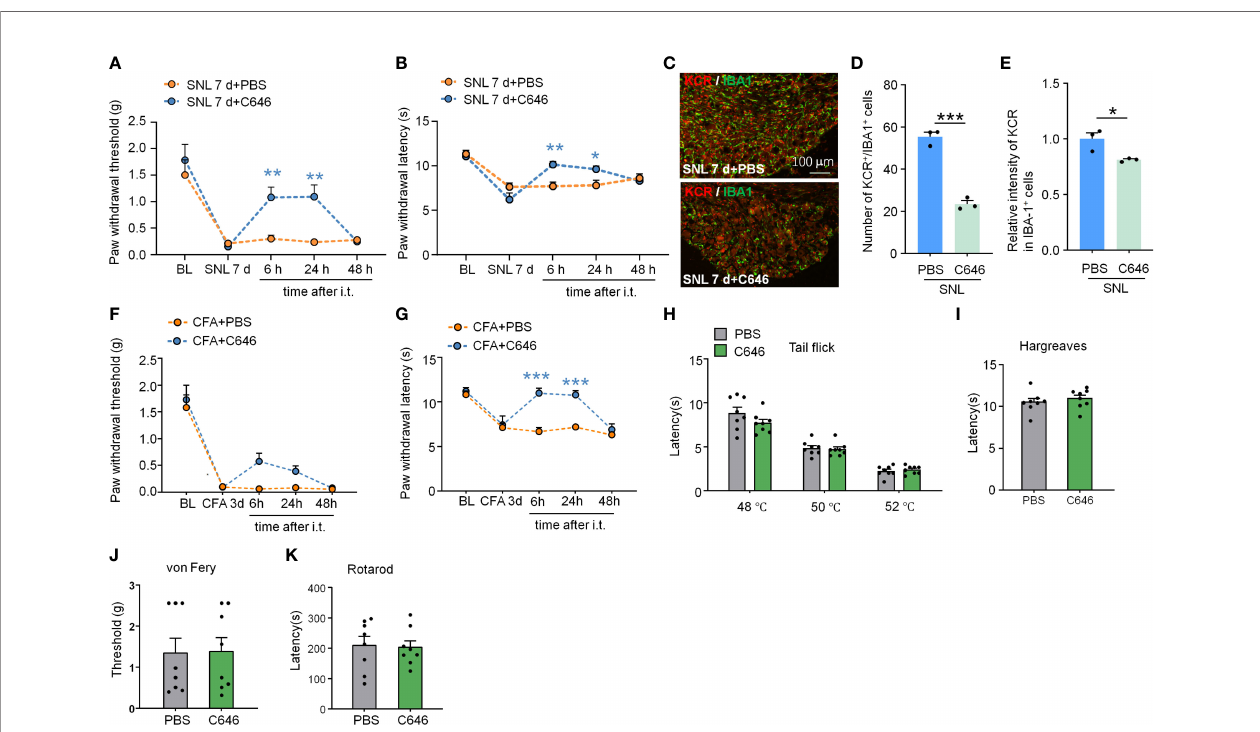
FIGURE 7 | Intrathecal administration of C646 attenuated SNL-induced neuropathic pain and CFA-induced in fl ammatory pain. (A, B) Intrathecal injection of C646 (2 m g) signi fi cantly relieved plantar mechanical pain and thermal pain hyperalgesia induced by SNL. * P <0.05, ** P <0.01, compared with the SNL+PBS group, n=6- 7 mice per group, Two-way RM ANOVA followed by Bonferroni ’ s test. (C – E) Representative images (C) and statistics of the number of KCR and IBA-1 double- positive cells (D) and the fl uorescence intensity of KCR in IBA-1 positive cells (E) 6 hours after intra-TG injection of PBS or C646 on SNL mice. * P <0.05, *** P <0.001, N = 3 mice per group, 3 sections per mice, student ’ s t-test. (F, G) Intrathecal injection of C646 signi fi cantly relieved plantar mechanical pain and thermal pain hyperalgesia induced by CFA. *** P <0.001, compared with the SNL+PBS group, n=8 mice per group, Two-way RM ANOVA followed by Bonferroni ’ s test.